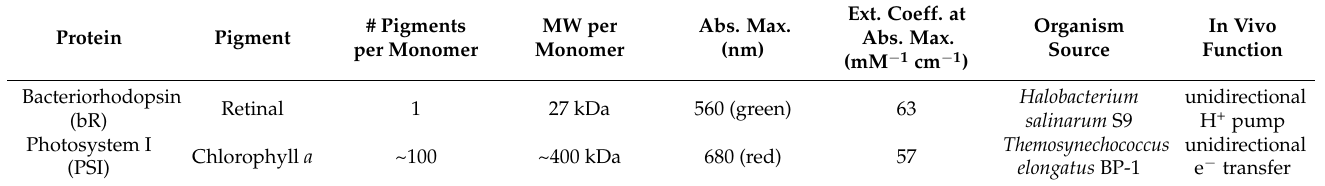
Figure 1. Structure of bacteriorhodopsin and photosystem I. Three-dimensional structure of pigment- protein complexes: ( A ) bacteriorhodopsin side view and ( B ) top view. ( C ) Photosystem I side view and ( D ) top view. The three subunits of bR are shown in orange, purple, and green respectively, with retinal shown in blue. In PSI, all of the protein is shown in teal with the chlorophyll light-harvesting antenna shown in green. For both proteins, the dashed line represents the position of the membrane each complex is embedded in vivo. Table 1. Properties of the pigment–protein complexes bacteriorhodopsin and photosystem